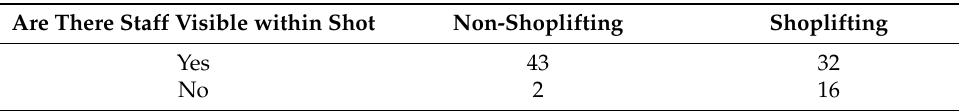
Table 6. Frequency of staff members being visible within a given scene. Are There Staff Visible within